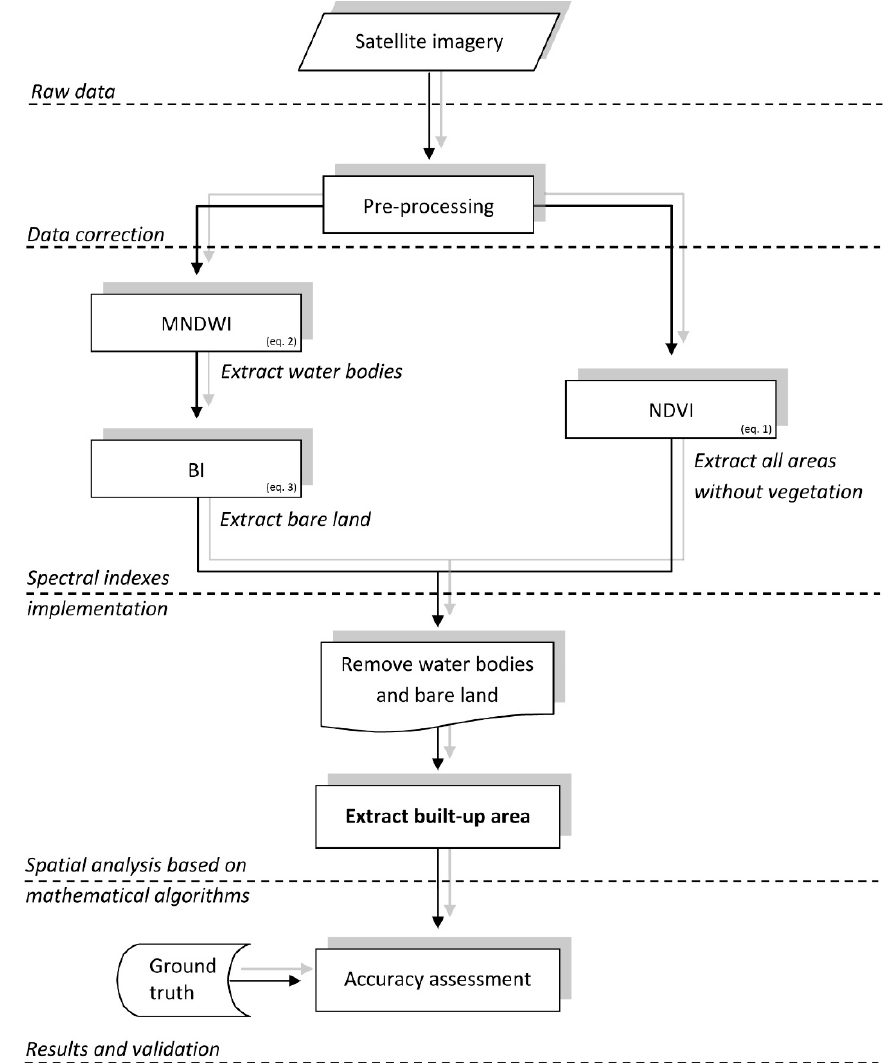
Figure 2. Workflow of the semi-automatic model proposed for built-up area mapping.